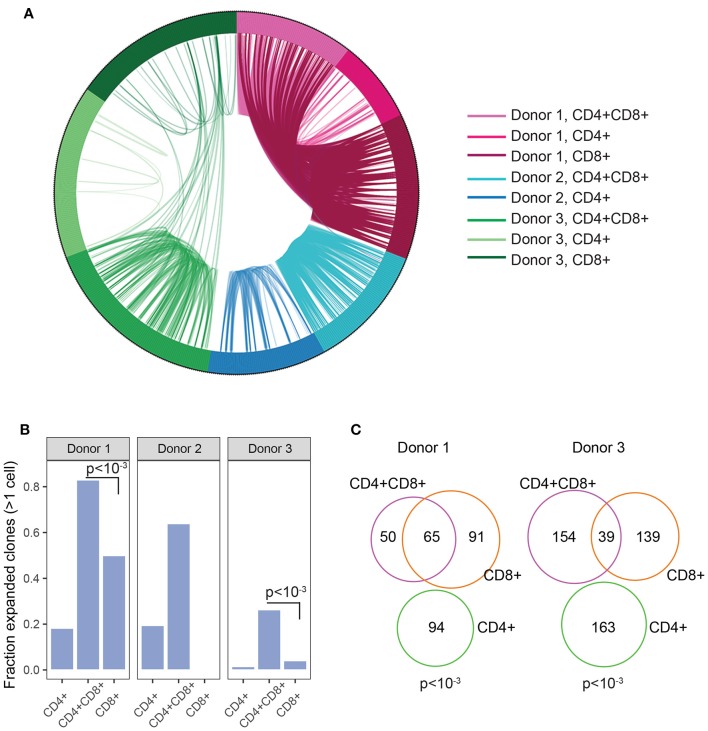
Clonal expansion in DP T cells. (A) Plot showing TCR sharing across CD4, CD8, and DP subsets from 3 donors. Each segment of the circle represents a cell with a rearranged TCR sequence and identical TCR rearrangements are connected with an arc. (B) Fraction of expanded clones across CD4, CD8, and CD4+CD8+ DP T subsets and donors. Clonal expansion was significantly higher in DP than in CD8 T cells in donor1 and donor3 (p < 10−3, indicated on plots) (C) Venn diagram representing TCR junction sharing across CD4+ (green circle), CD8+ (orange circle) and CD4+CD8+DP (purple circle) T cell subsets for donor 1 and donor 3. Numbers represent the number of TCR junctions analyzed. Fischer's p values are indicated on plot.